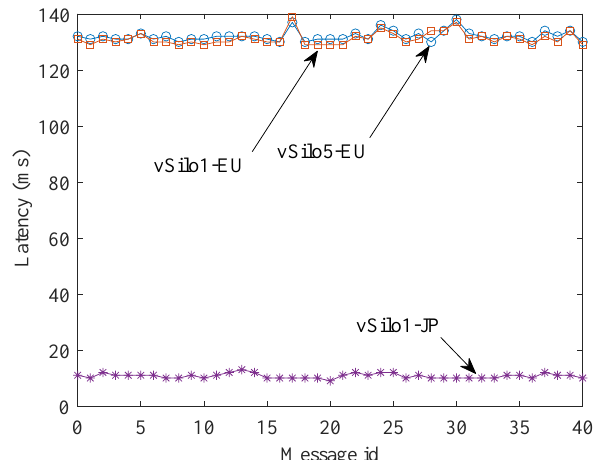
Figure 10. Latency of context data.